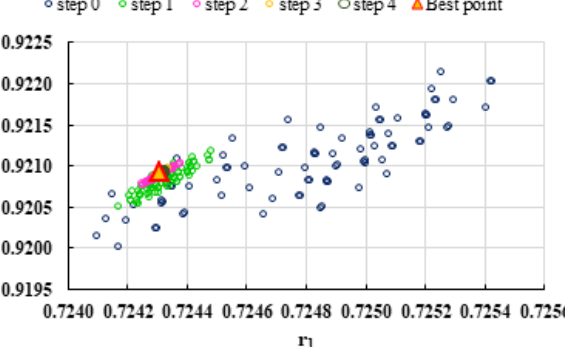
Figure 2. Distribution of P cen ( r 1 , r 2 ) points for each step of searching for the k-NN method for the conditions imposed by LC2.